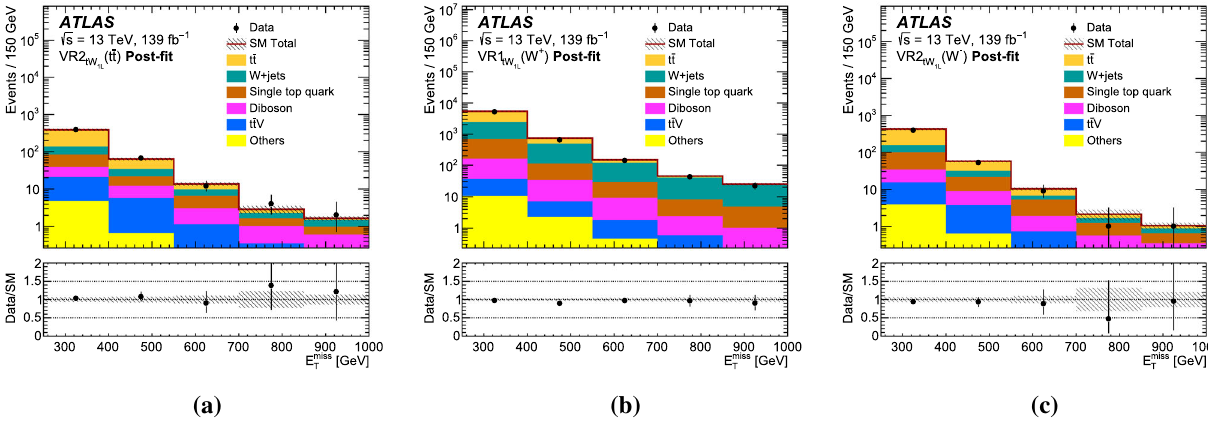
Fig. 2 The E miss processes such as triboson, t ¯ tt ¯ t , t ¯ tWW , and Higgs boson production distributions after the background-only fit (post-fit) T ( t ¯ t ) , processes. The overflow events, where present, are included in the last are shown in three representative validation regions: a VR2 tW 1L bin. The lower panels show the ratio of data to the background predic- tion. The hatched error bands indicate the combined experimental and include all statistical and systematic uncertainties. The ‘Others’ cate- MC statistical uncertainties on these background predictions gory includes contributions from Z +jets and tW Z production, and rare